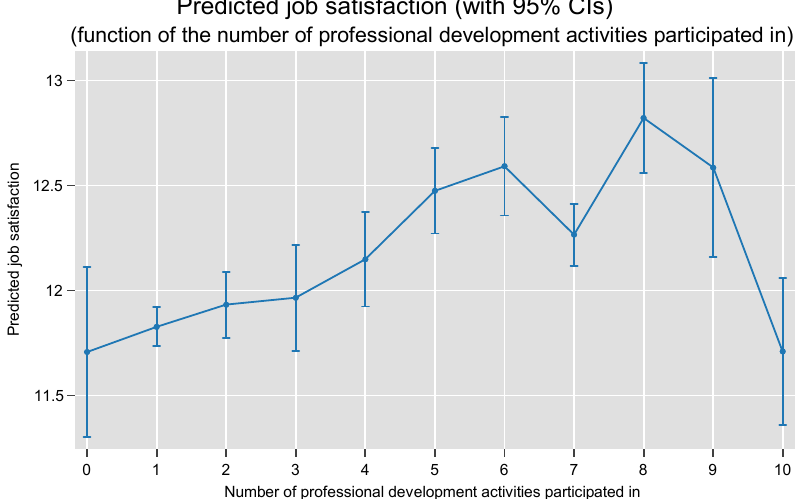
Figure 3. Predicted job satisfaction as a function of the number of professional development activities participated in.